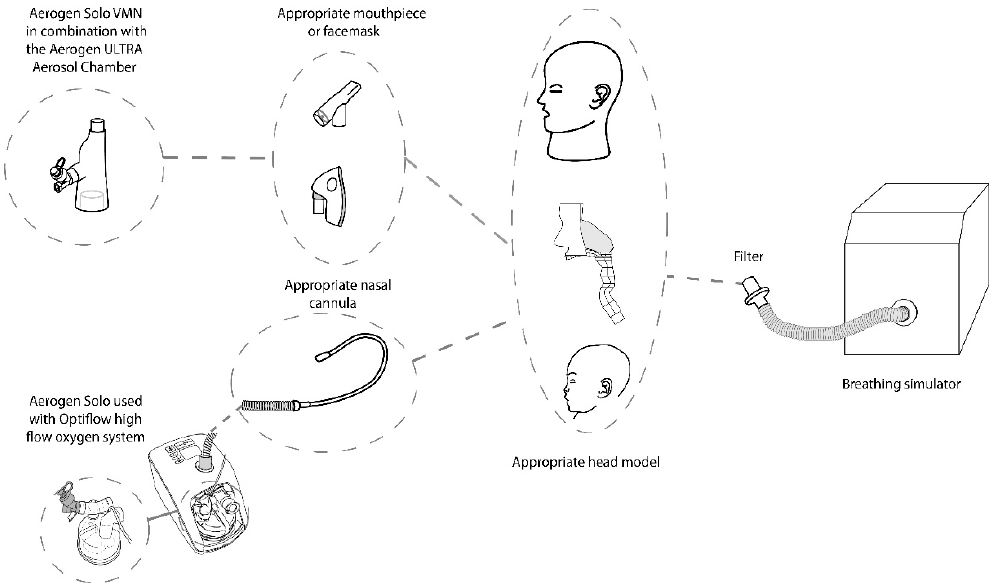
Figure 2. Experimental Set-up: Head model set-up in combination with the ASL 5000 breathing simulator. Aerosol administration provided with the Aerogen Ultra with a facemask or mouthpiece and the Aerogen Solo/Airvo 2 with Optiflow Nasal cannula at supplemental flow rates of 0, 2 and 6 LPM and high flow gas rates of 10 and 50 LPM respectively.